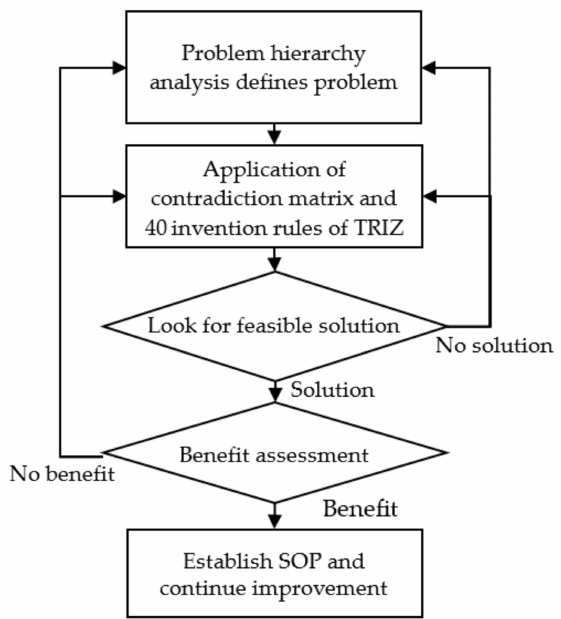
Figure 1. Research